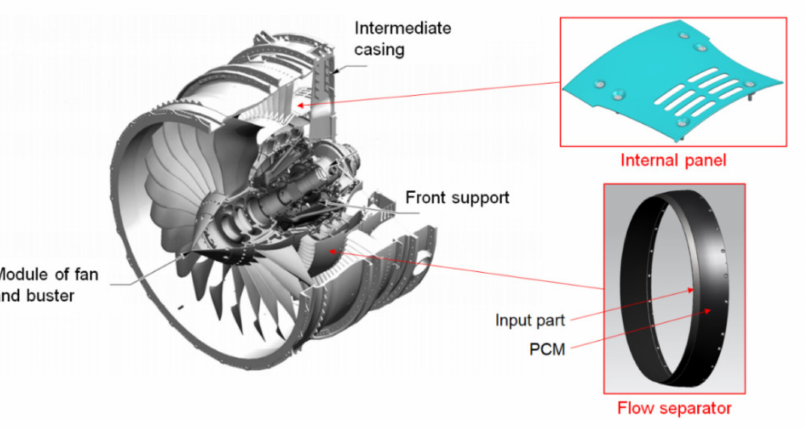
Figure 1. FS and inner panel in